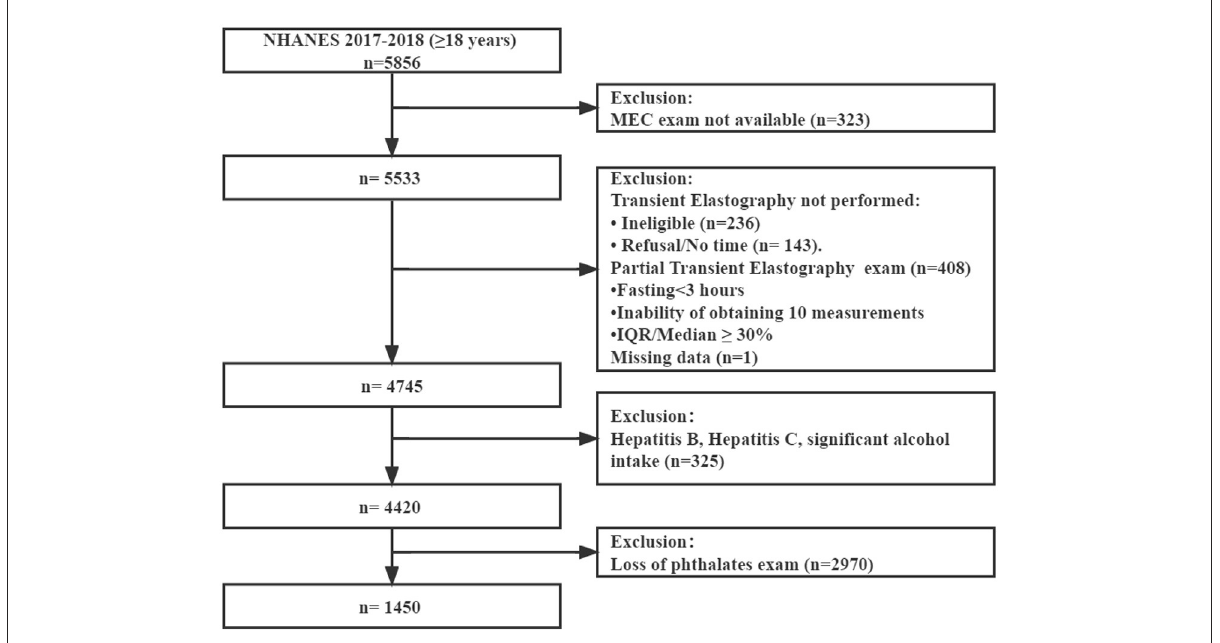
FIGURE1 Data reduction